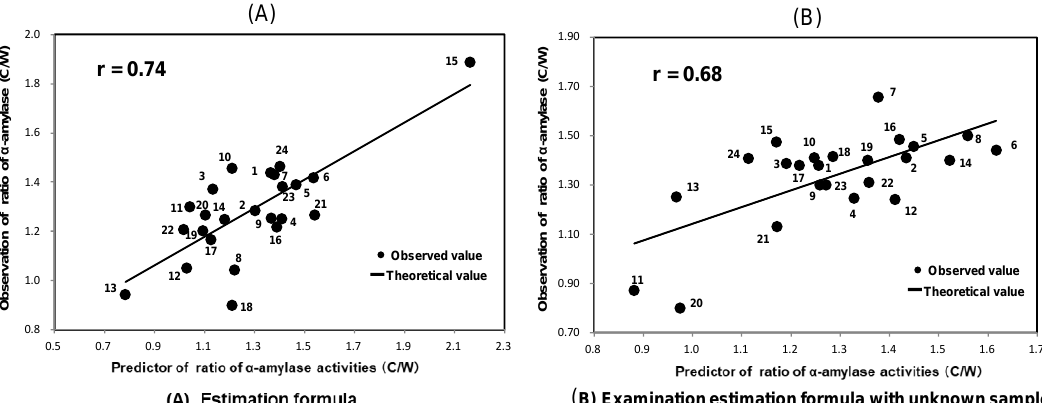
Figure 4. The estimating formula for the ratios of α -amylase activities of chalky unpolished grains to those of whole ones of Japonica rice except low-amylose rice based on the pasting properties in original Japonica rice using RVA. ( A ) Estimation formula; ( B ) Examination estimation formula with unknown samples. C, chalky grains; W, whole grains; ratios of α -amylase activities (C/W), ratios of α -amylase activities of chalky grains to those of whole ones.